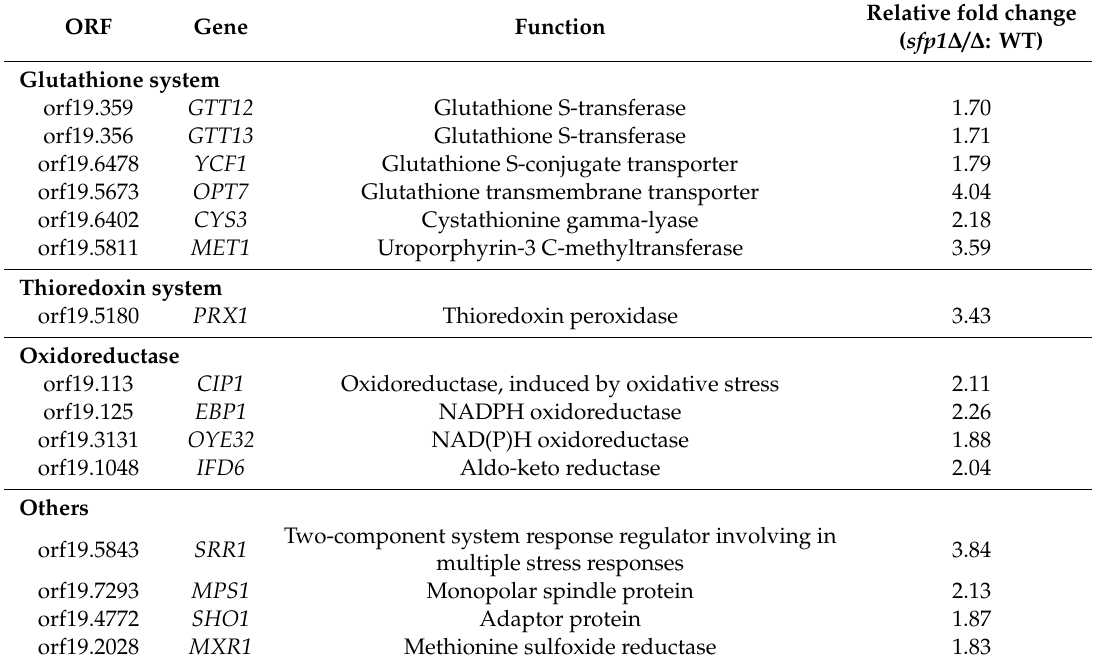
Relative fold change